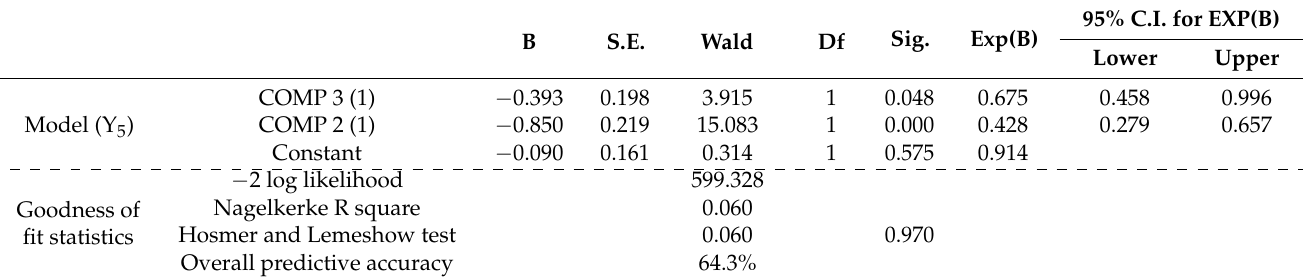
Table 11. Multivariate regression results between disruption of academic activities and predictor